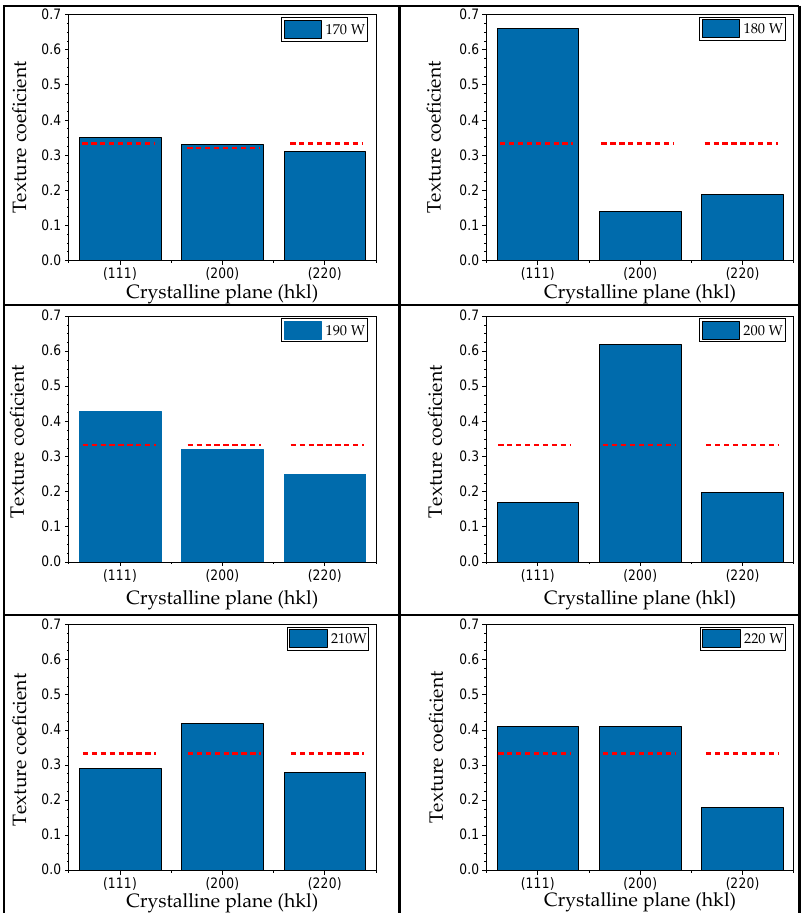
Figure 4. Texture coefficients calculated from the peak intensities for the different samples.